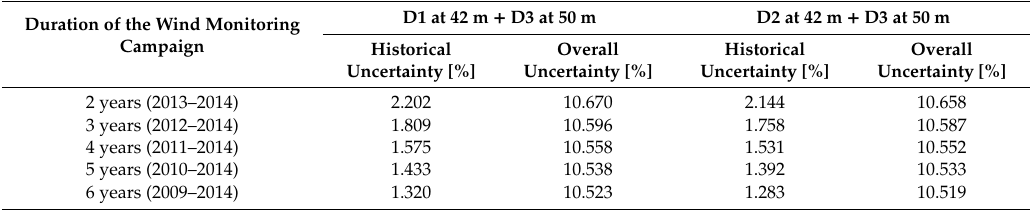
Table 6. Overall uncertainty of combinations of data from D1 or D2 (both at 42 m) and D3, considering different lengths.